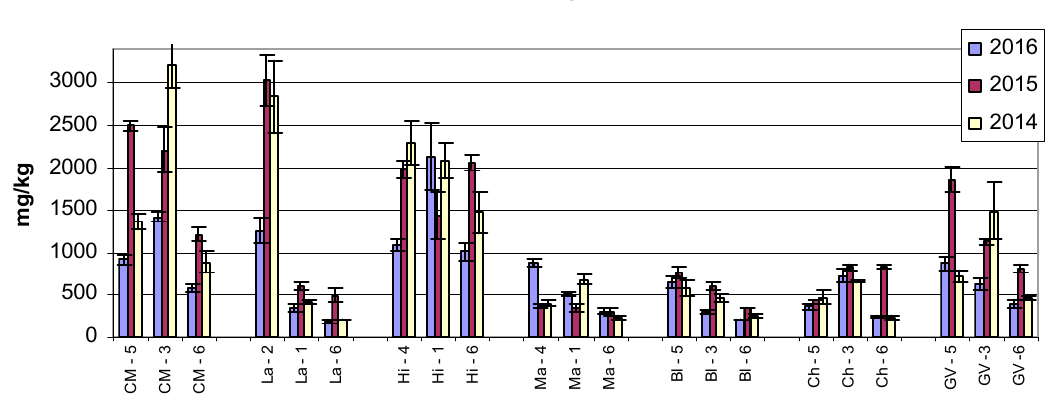
Figure 3. Contents of r2-viniferin in grape canes during three years. Example explanation of abbreviations: CM-5—“CM” is the variety, “5” is the sampling site (see Materials and Methods and Table 1).